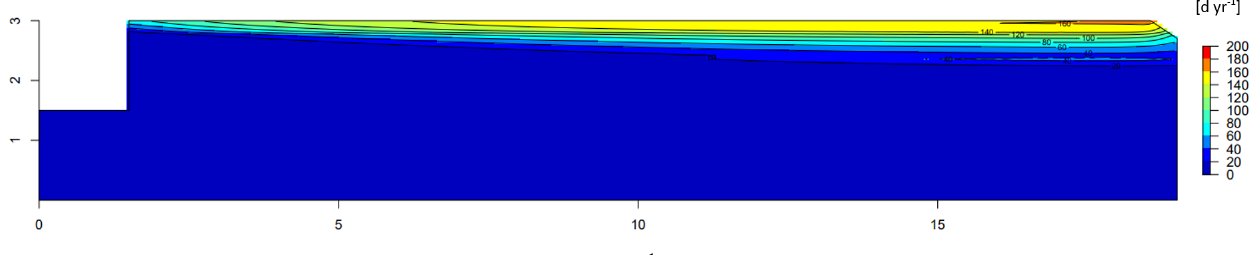
Figure 3. Model domain with estimated potential respiration rate (dyr − 1 ) for a model